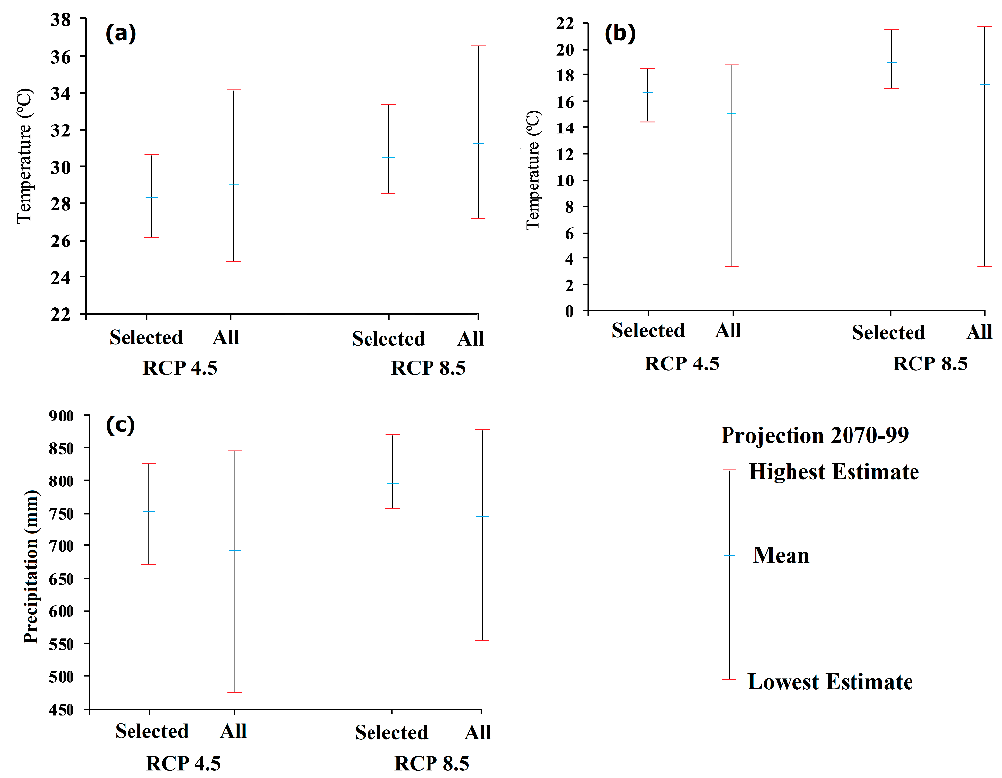
Figure 7. The projections of ( a ) maximum temperature; ( b ) minimum temperature; and ( c ) precipitation during 2070–2099 obtained using the selected GCMs and all GCMs.